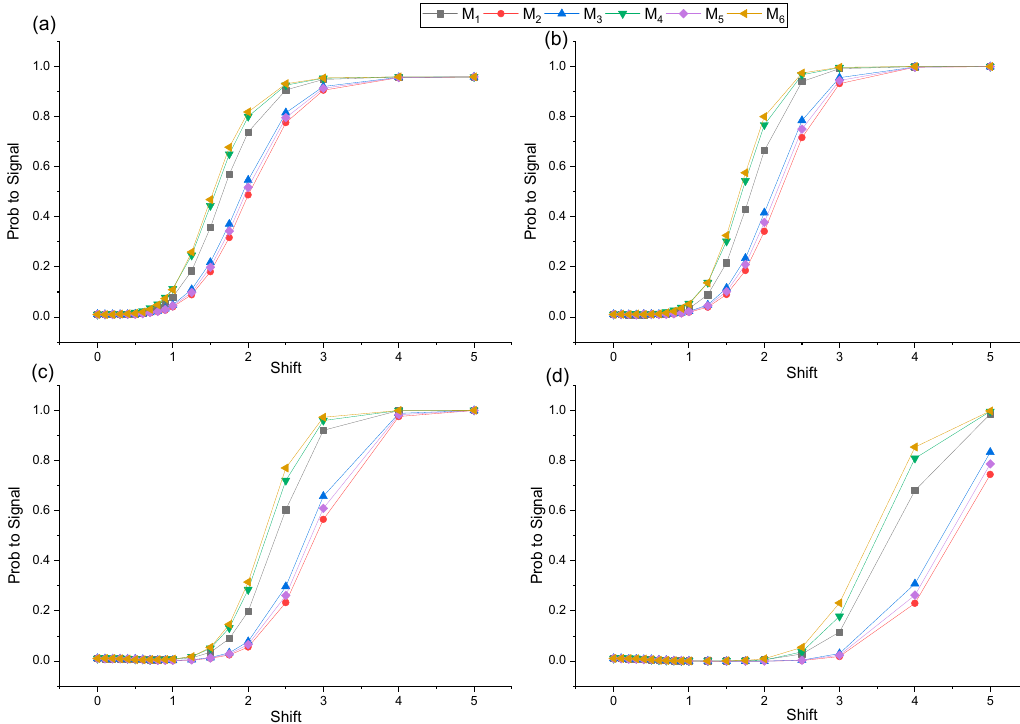
Figure 3. Probability to signal plot for di ff erent auxiliary information based median charts using n = 10, m = 30, ρ = 0.50 and α = 0.01 at ( a ) m 1 = 3, ( b ) m 1 = 6, ( c ) m 1 = 9, ( d ) m 1 = 12. Table 2. Control chart multipliers (𝐾 (cid:3028) ) for obtaining 𝛼 = 0.01 using 𝑛 = 10 at different levels of 𝜌 .